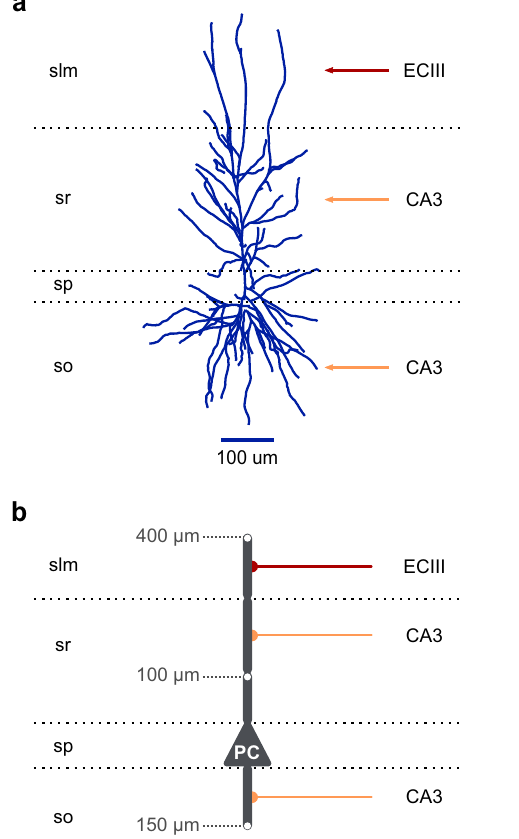
Fig.7|Frombiologicalneuronstoreducedcompartmentalneuronmodels.a A morphologically detailed reconstruction of a human CA1 PC (adopted from NeuroMorpho.Org 103 ). Red arrow: EC layer III input, orange arrows: CA3 input. Horizontal dotted lines: borders of the four CA1 layers (slm: stratum lacunosum- moleculare, sr: stratum radiatum, sp: stratum pyramidale, so: stratum oriens). b Schematic illustration of a basic fi ve-compartment CA1 model consisting of a somaticandfourdendriticsegments(1×basal,1×proximaltrunk,1×distaltrunk,1× tuft). Grey numbers: distance of the indicated points from the soma. Red axon: EC layer III input, orange axons: CA3 inputs. Horizontal dotted lines: borders of the four CA1 layers as in panel ( a